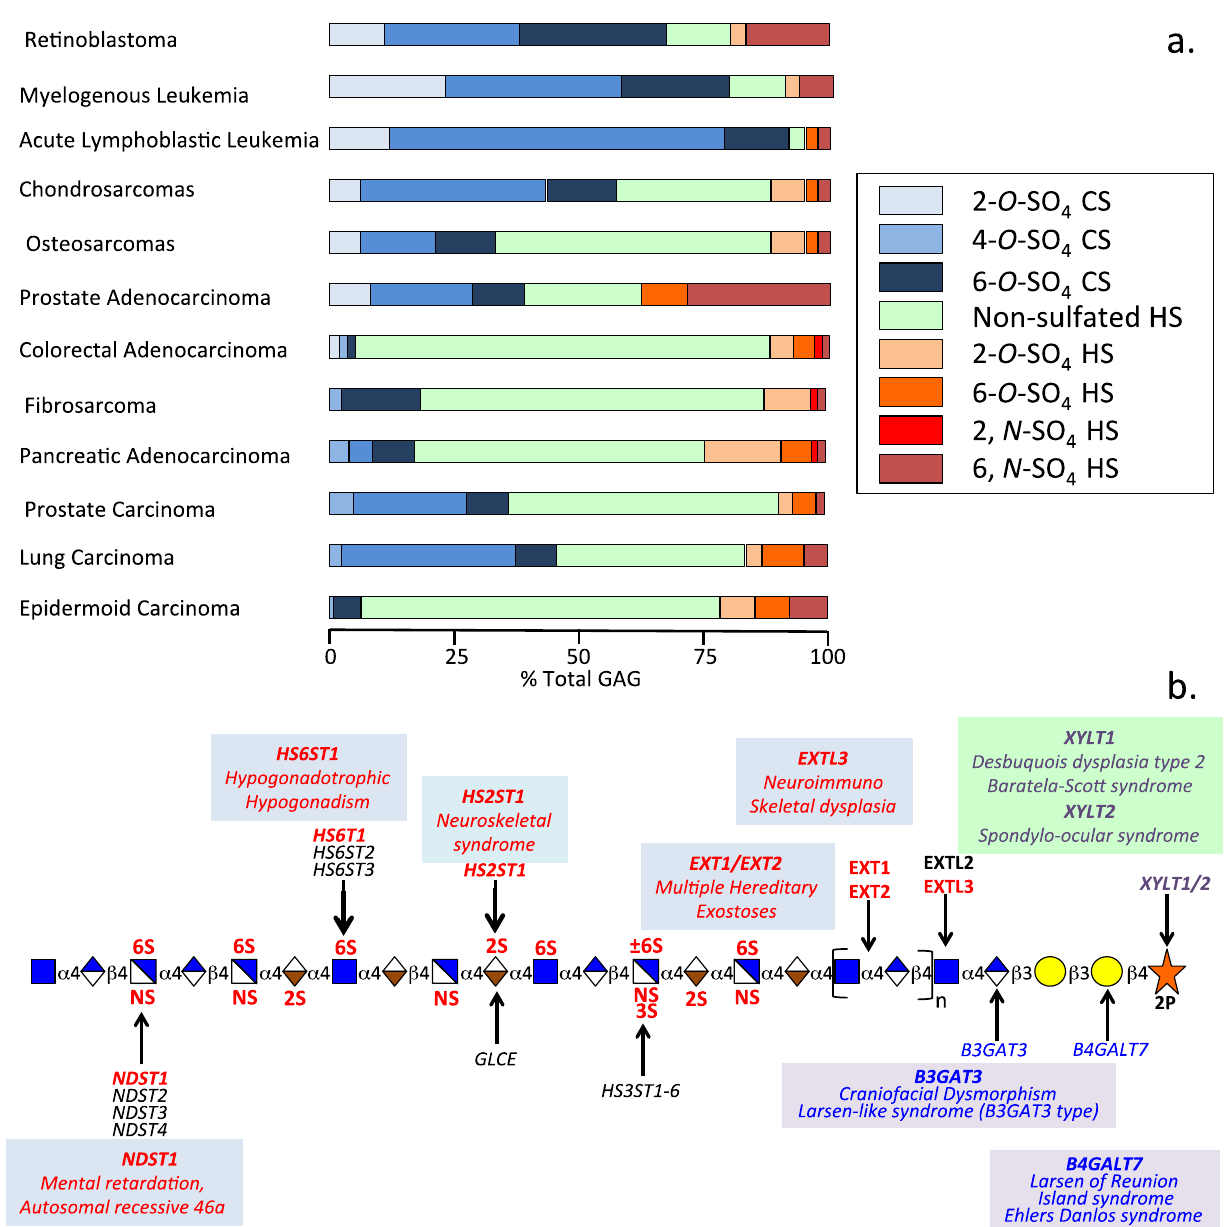
Figure 3. Variation in the sulfation patterns of CS and HS in cancer ( a ) and mutations in HS sulfation enzymes associated with several musculoskeletal disorders ( b ). Data modified from Basu et al. [24] Reproduced under the Creative Commons Attribution CC-BY 4.0. with permission of The American Physiological Society.